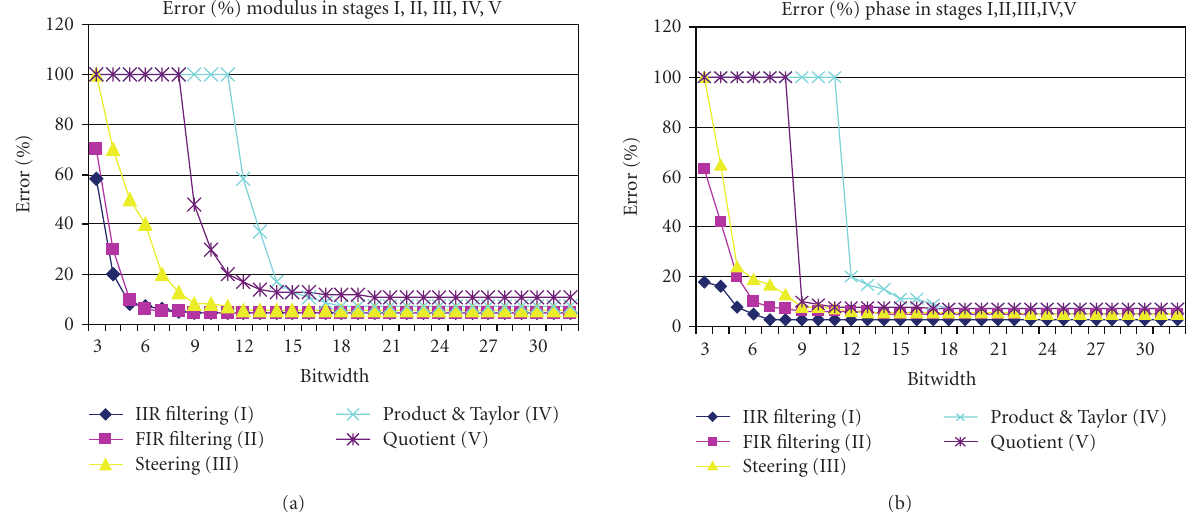
Figure 2: Evaluation of the bit width needed in the modulus (a) and phase (b) converting the data to fixed point.